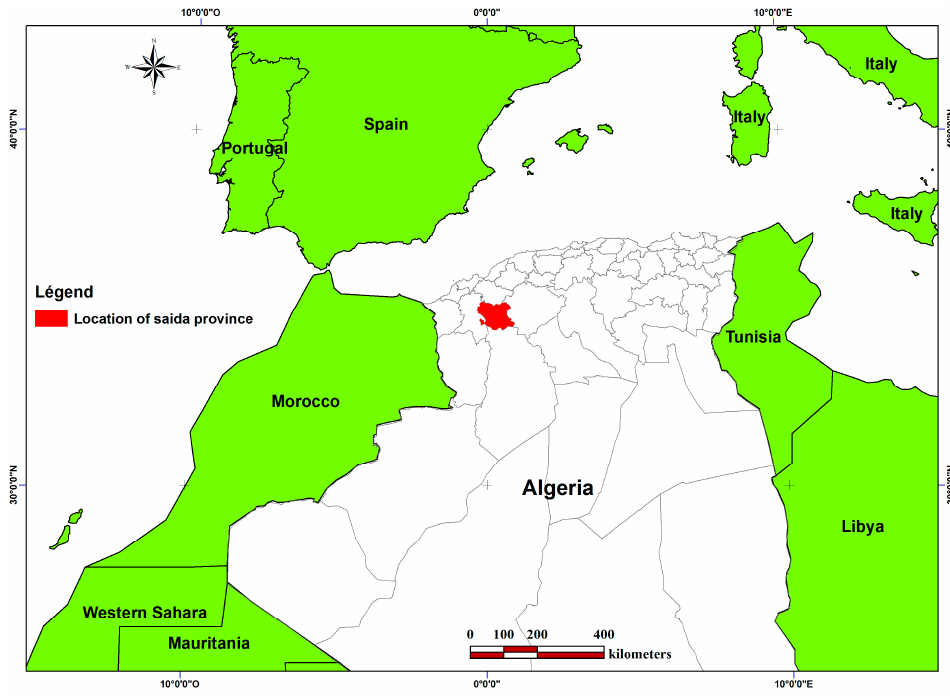
Figure 7. Situation map of Saïda Province.